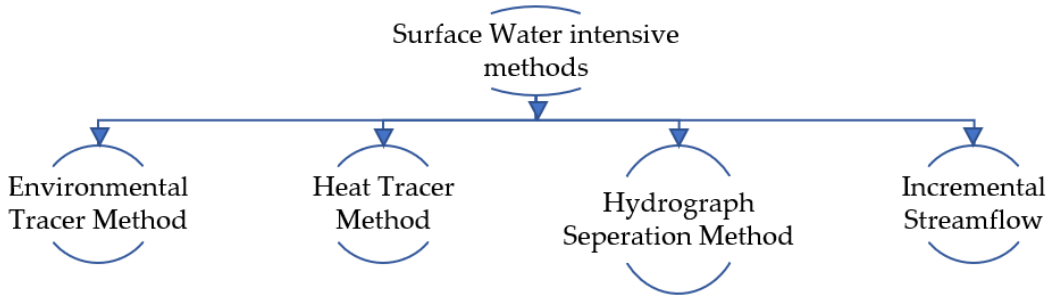
Figure 9. Methods for quantifying surface water interaction with groundwater.